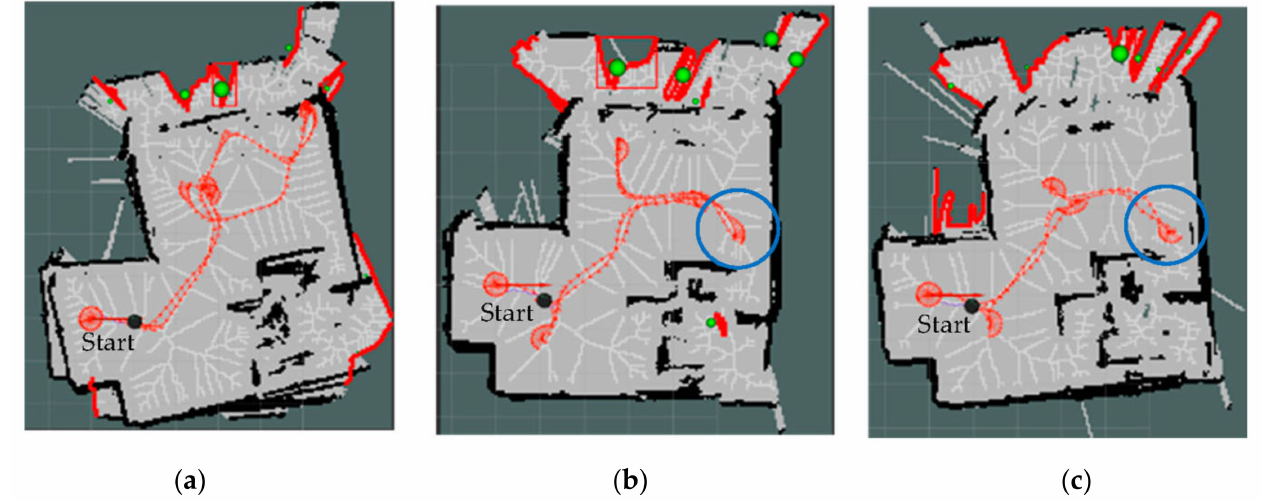
Figure 5. Exploration paths of the low-texture environment, the bold red clusters are the ignored inaccessible frontiers, and the green balls represent the centroids of the frontiers. ( a ) D strategy, ( b ) M strategy, and ( c ) M+D strategy.